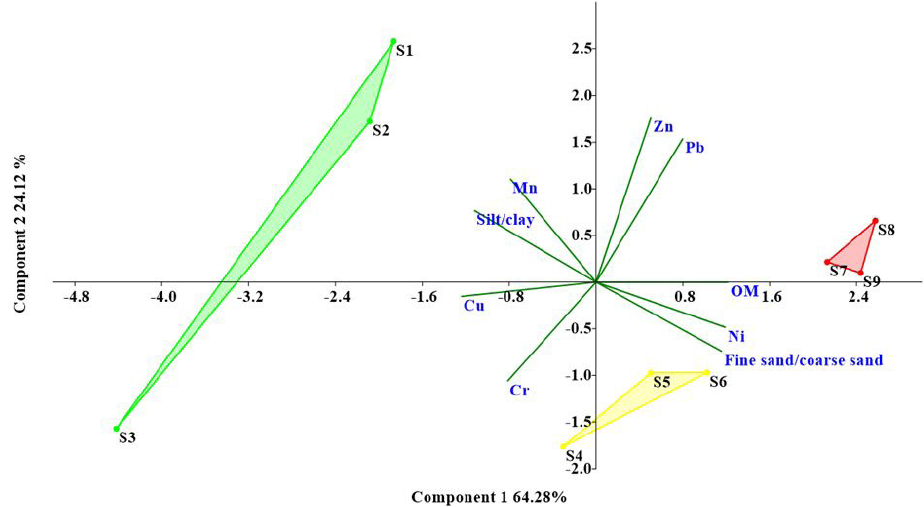
Figure 6. Principal component analysis (PCA) of metal samples and percentage distribution of organic matter and granulometry. The PCA shows the separation among the sampling collection stations (S), through the components 1 and 2, correlating the OM and the granulometric fractions with the metal concentrations present in the